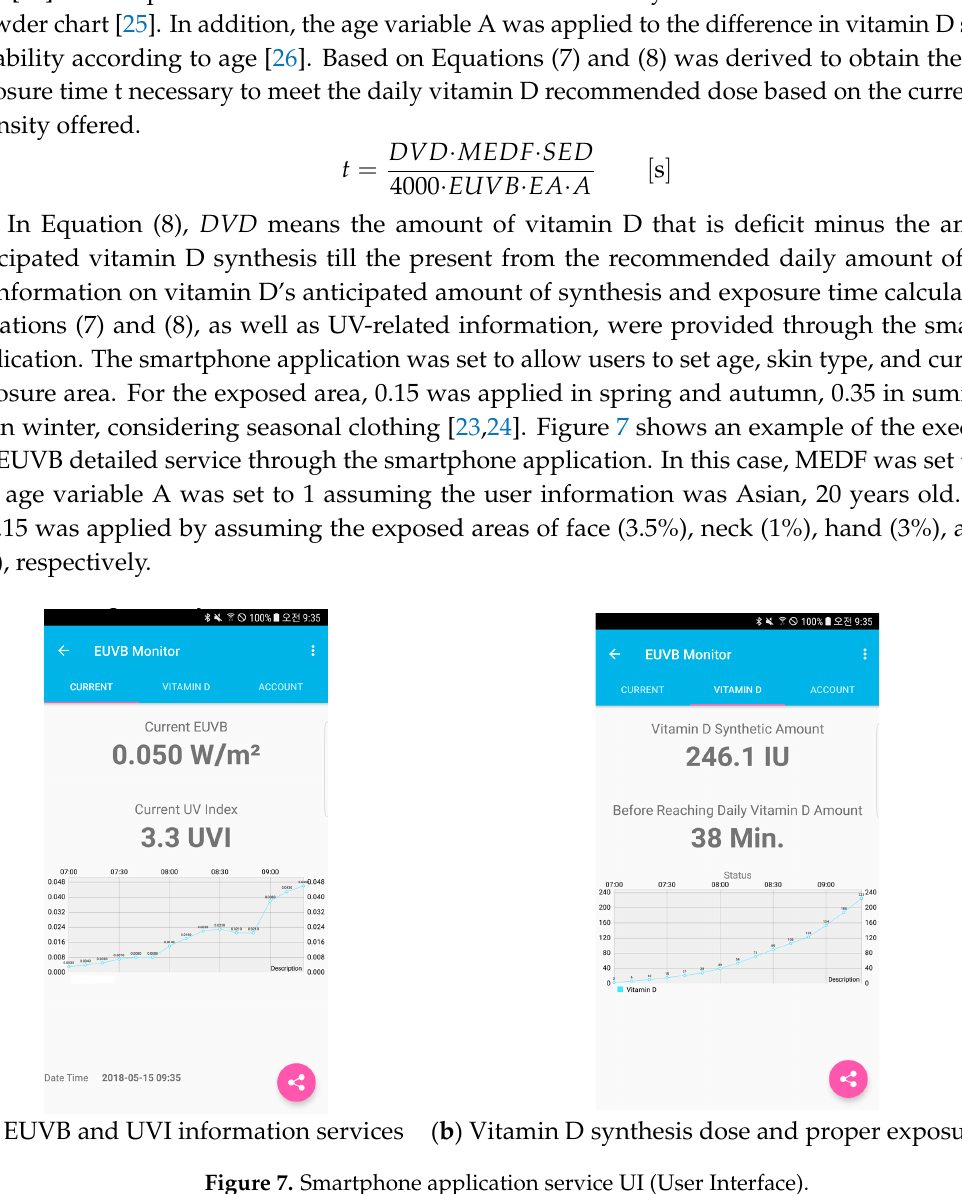
Figure 7. Smartphone application service UI (User Interface).